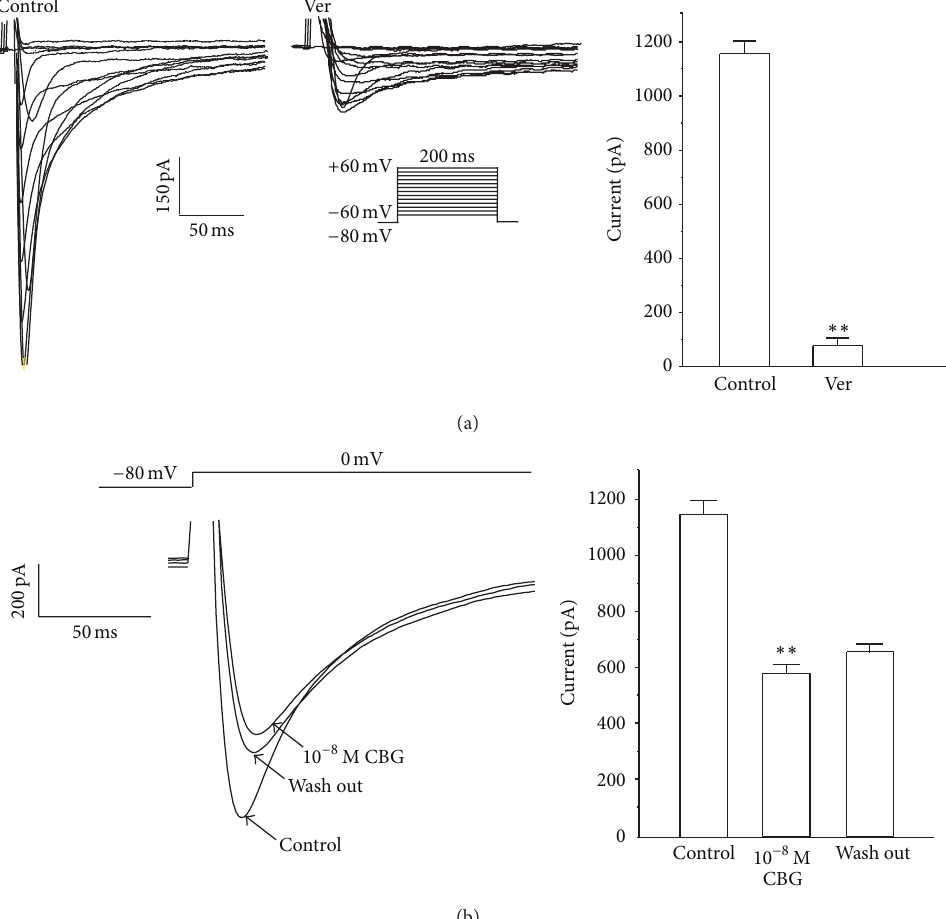
Figure 2: Ver (0.1 mM) completely blocks 𝐼 activation protocol before and after application of Ver. Summary data of 𝐼 control conditions, during exposure to 10 −8 M CBG and during wash out. Data are means ± S.E.M. ( 𝑛 = 6 cells). ∗∗ 𝑃 < 0.01 , versus